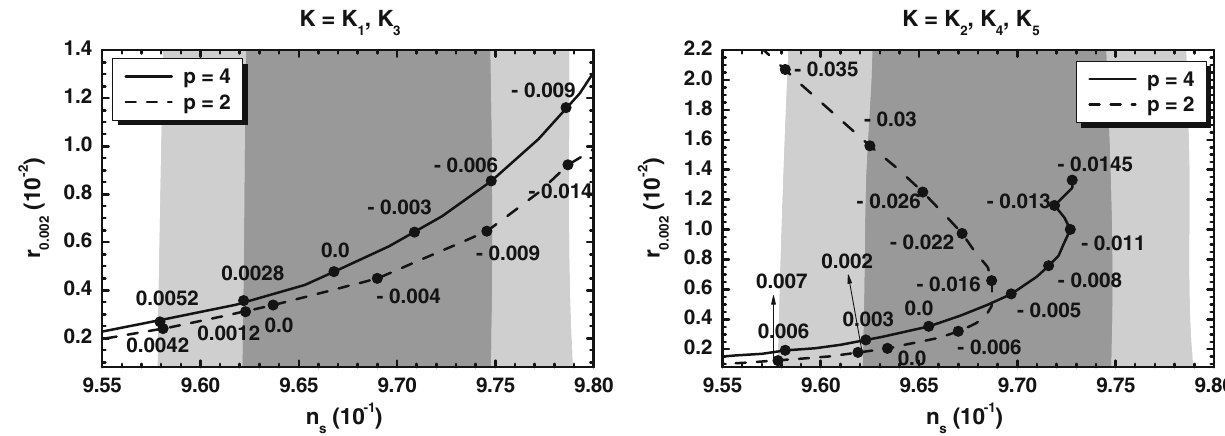
Fig. 1 Allowed curves in the n s − r 0 . 002 plane for p = 2 (dashed lines) and p = 4 (solid lines), K = K 1 and K 3 (left plot) or K = K 2 , K 4 and K 5 (right plot) with the various n ’s indicated on the lines. The marginal-